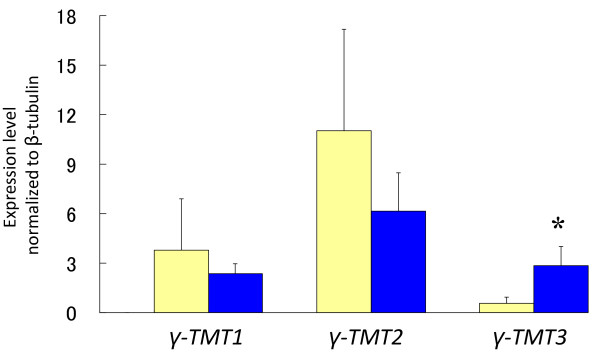
Gene expression analysis of γ-TMT1, γ-TMT2, and γ-TMT3 in leaves of Ichihime and KAS. Quantitative RT-PCR was performed on total RNA from leaves using the gene-specific primers listed in Table 5. Yellow bars represent Ichihime and blue bars represent KAS. Transcript levels were normalized with the values obtained for the internal control (β-tubulin mRNA). Values represent the mean of three replicates ± SD. Asterisks show significant difference between the Ichihime genotype group and the KAS genotype group (confidence interval 95%).